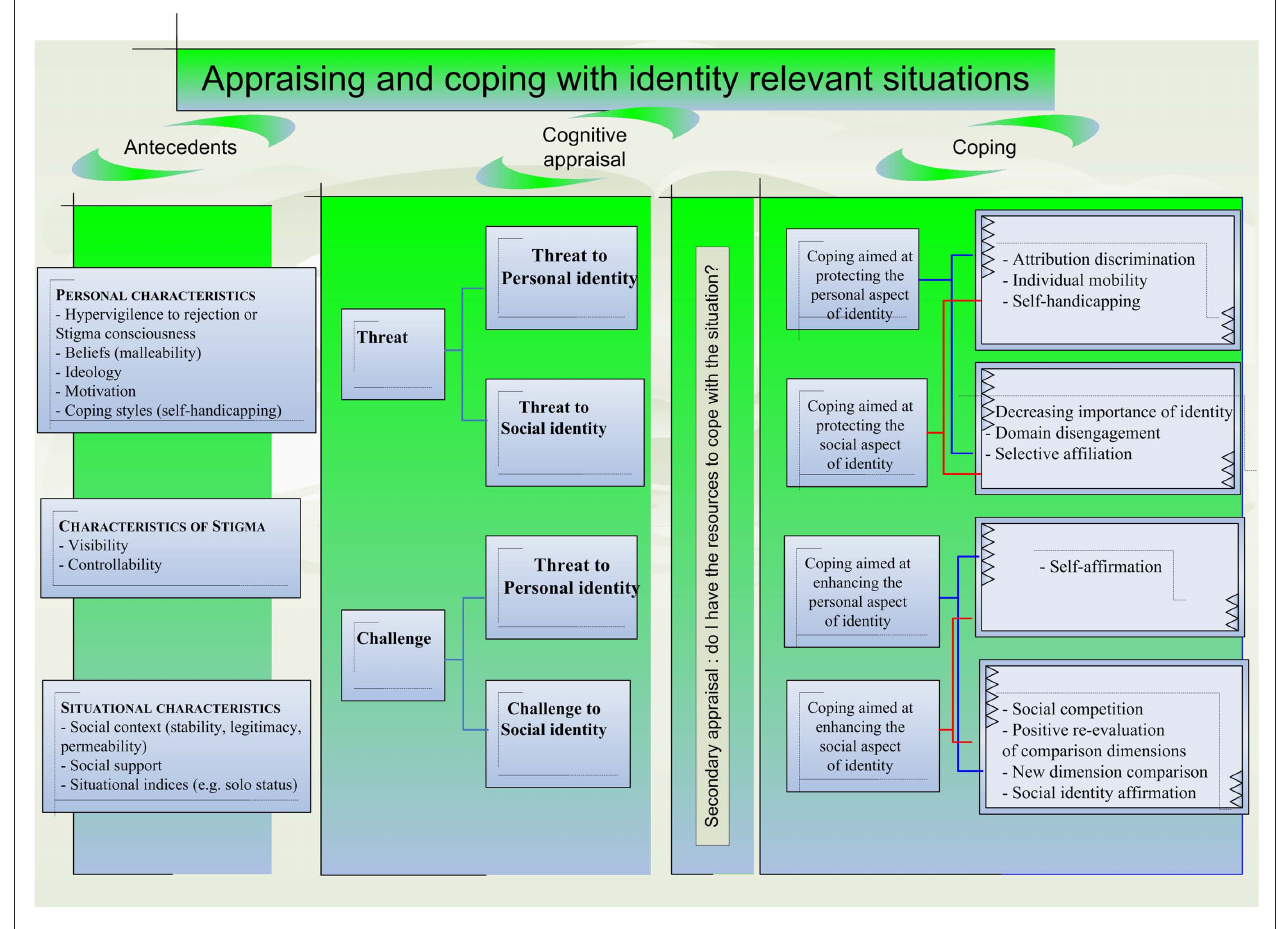
Figure 1 | Appraising and coping with identity relevant